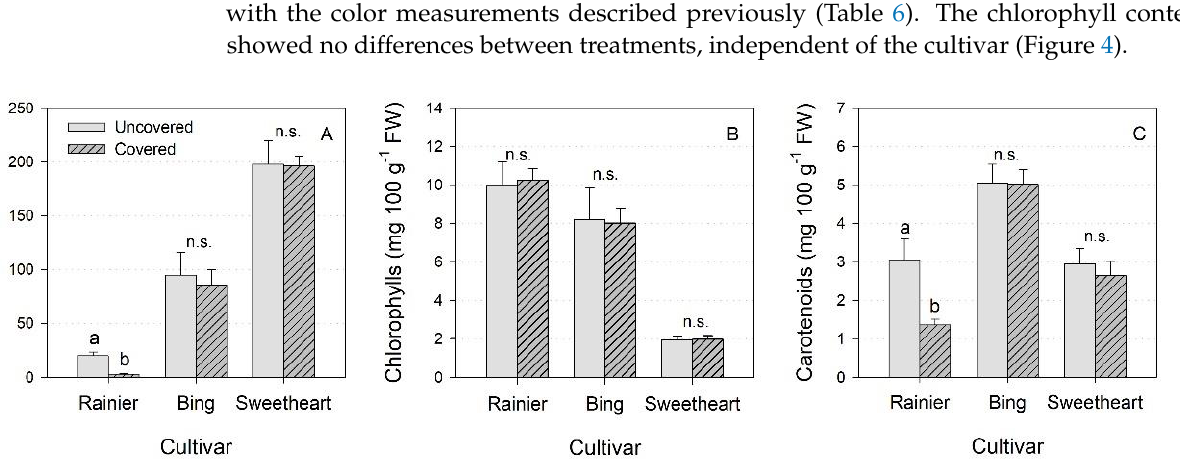
Figure 5. ( A ) Total phenol content and ( B ) ORAC antioxidant capacity of ‘Rainier’, ‘Bing’ and ‘Sweetheart’ sweet cherries with and without rain cover. Columns of a cultivar followed by the same letters indicate no statistical difference between treatments according to Tukey ’s test ( p ≤ 0.05). Means + SE ( n = 5).